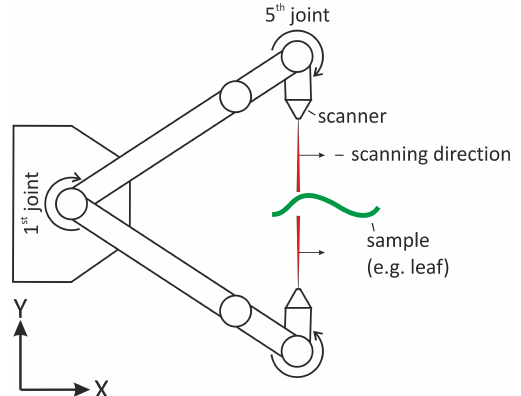
Figure 2. Measuring setup of leaf thickness measurements. Using this setup, only the first and the fifth joint are changed a lot when scanning the sample from both sides. All other joints are only changed slightly during the measurement